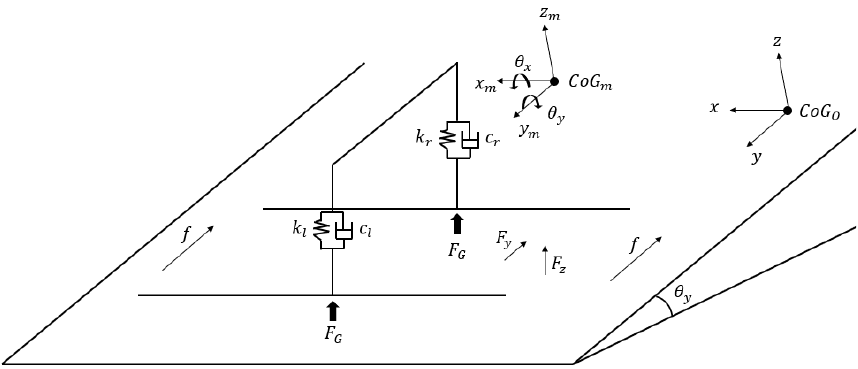
Figure 2. Schematic of the general multi-purpose platform model.